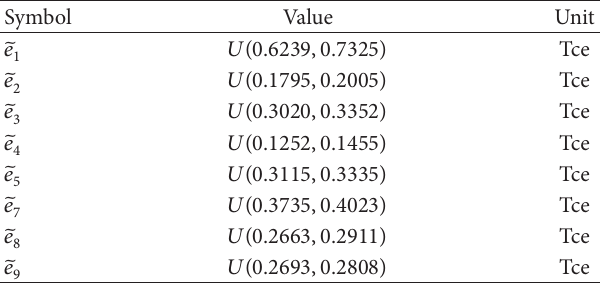
Table 5: Data of the random variables.